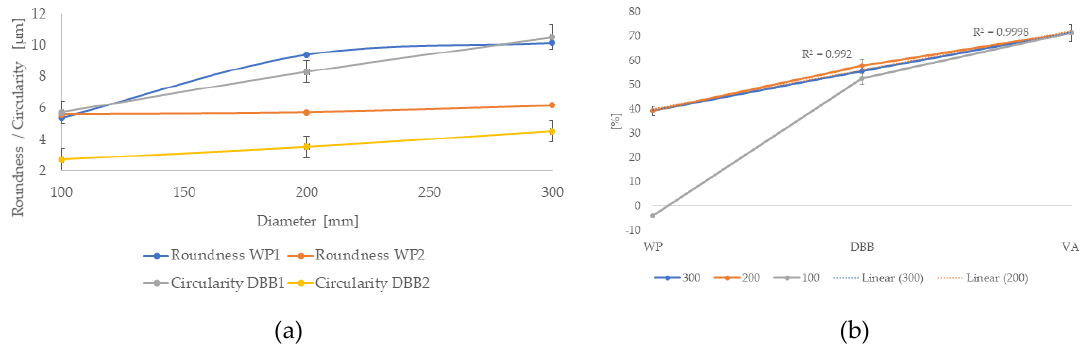
Figure 18. ( a ) Diagrams of the dependence between machine circularity error and ( b ) workpiece